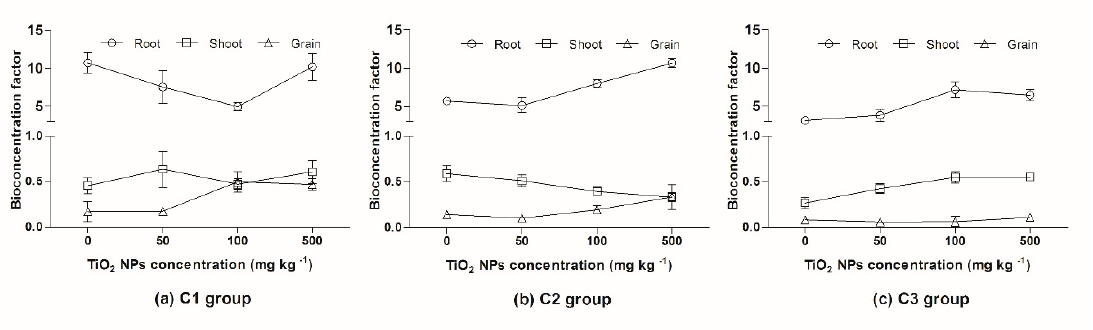
Figure 6. Changes in the Cd bioconcentration factor. ( a ) C1 group, ( b ) C2 group, ( c ) C3 group.